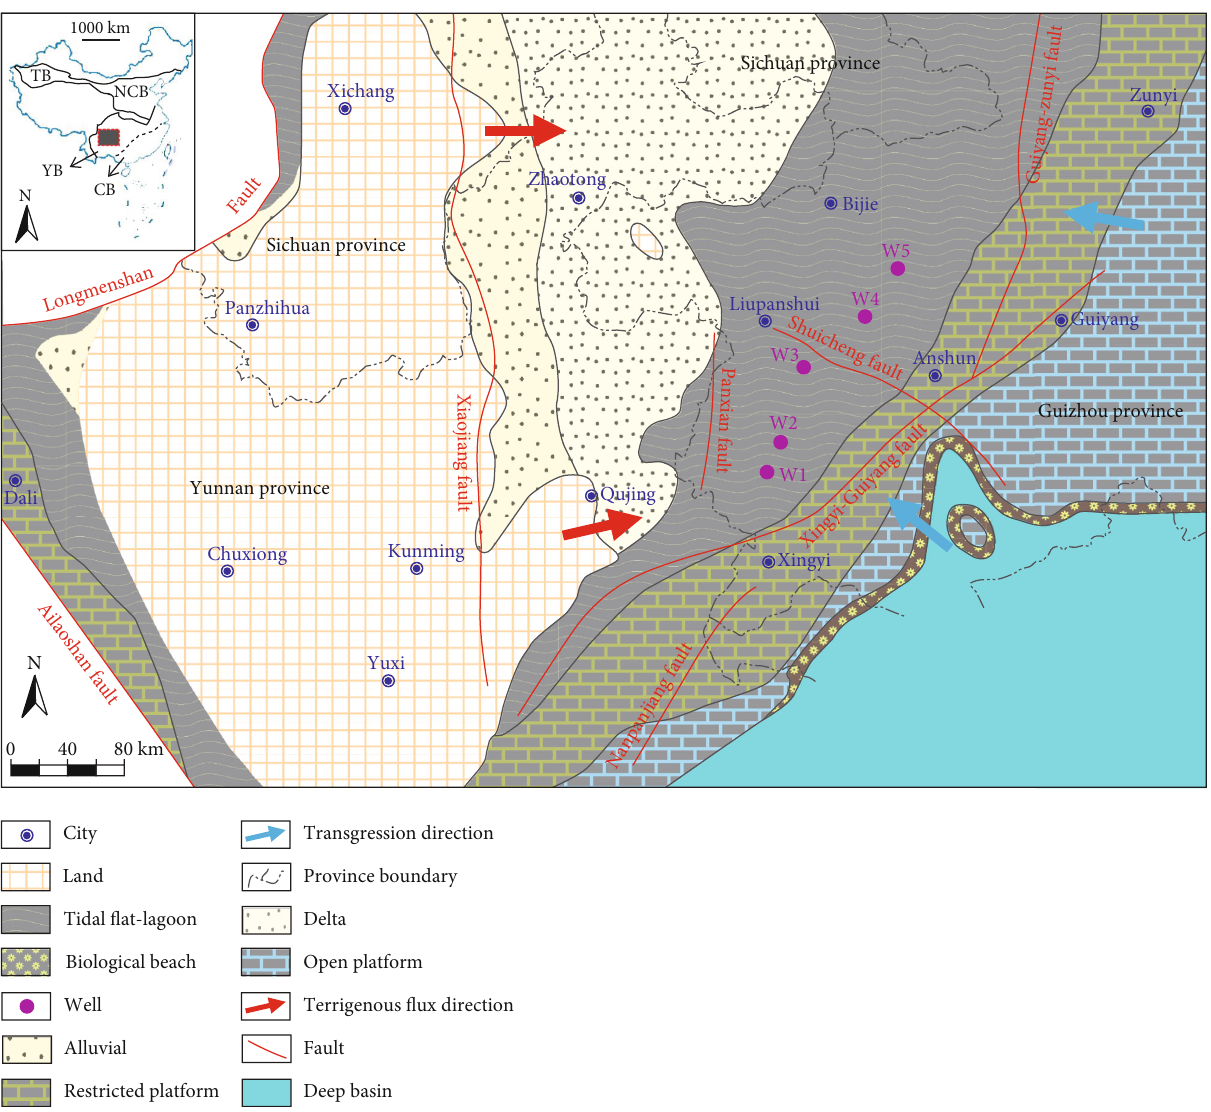
Figure 1: Lithofacies palaeogeography of western Yangtze platform in the Late Permian and the sampling position of this study (the basemap is modi fi ed from [17, 27]). TB: Tarim Block; NCB: North China Block; YB: Yangtze platform; CB: Cathaysia